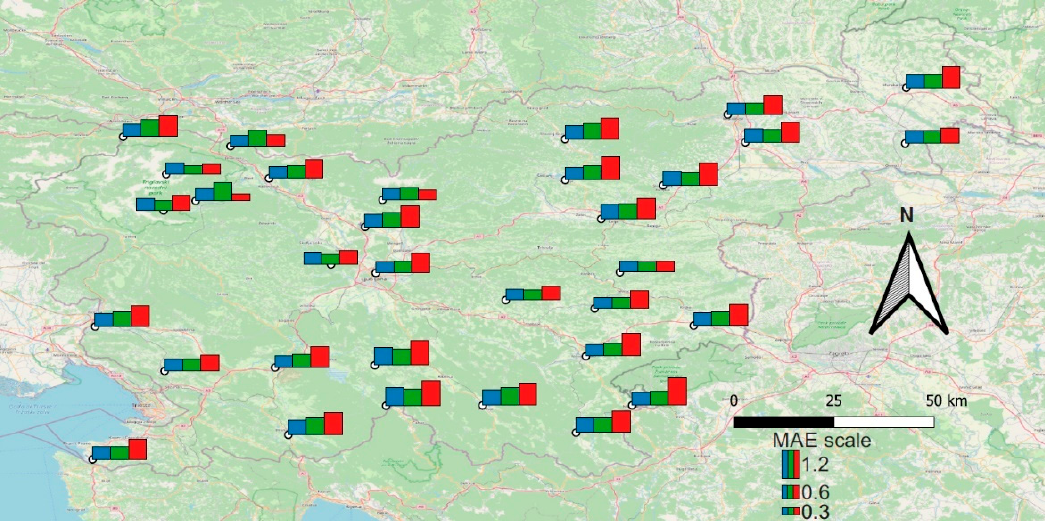
Figure 2. Mean Absolute Error (MAE) values between Equations (1) and (2) (blue bar), Equations (1)–(3) (green bar), and Equations (1)–(4) (red bar) using mean daily air temperature data.